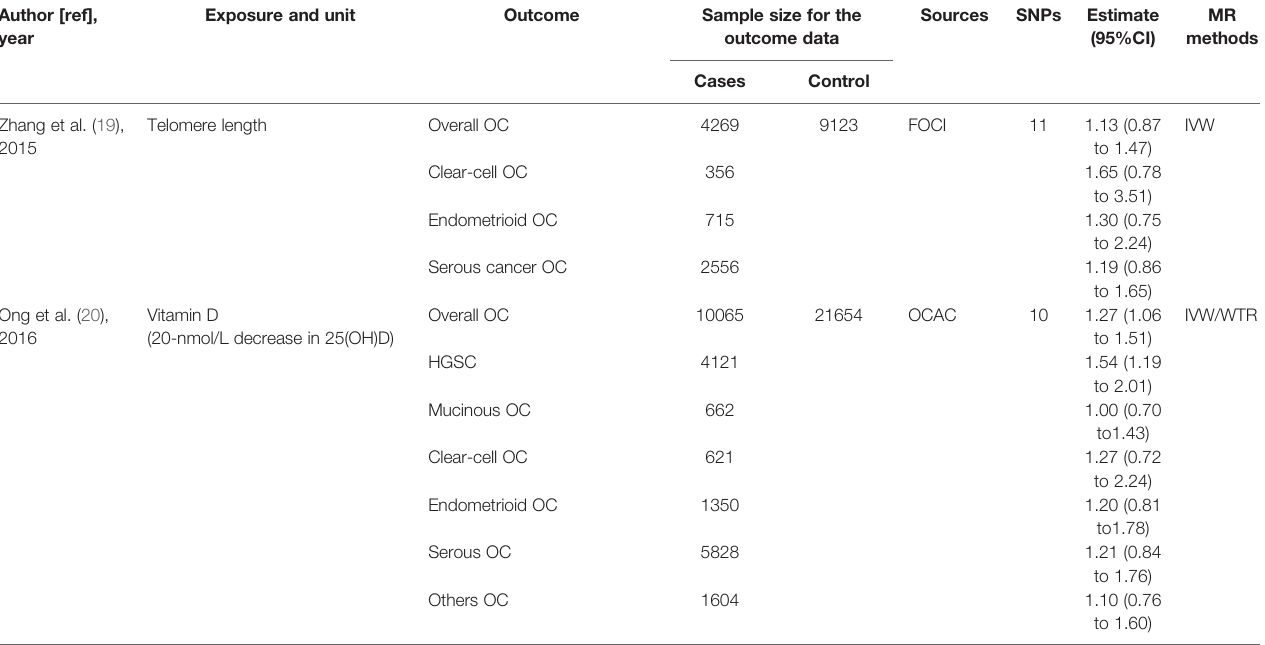
TABLE 1 | Characteristics of Mendelian randomization studies included in the